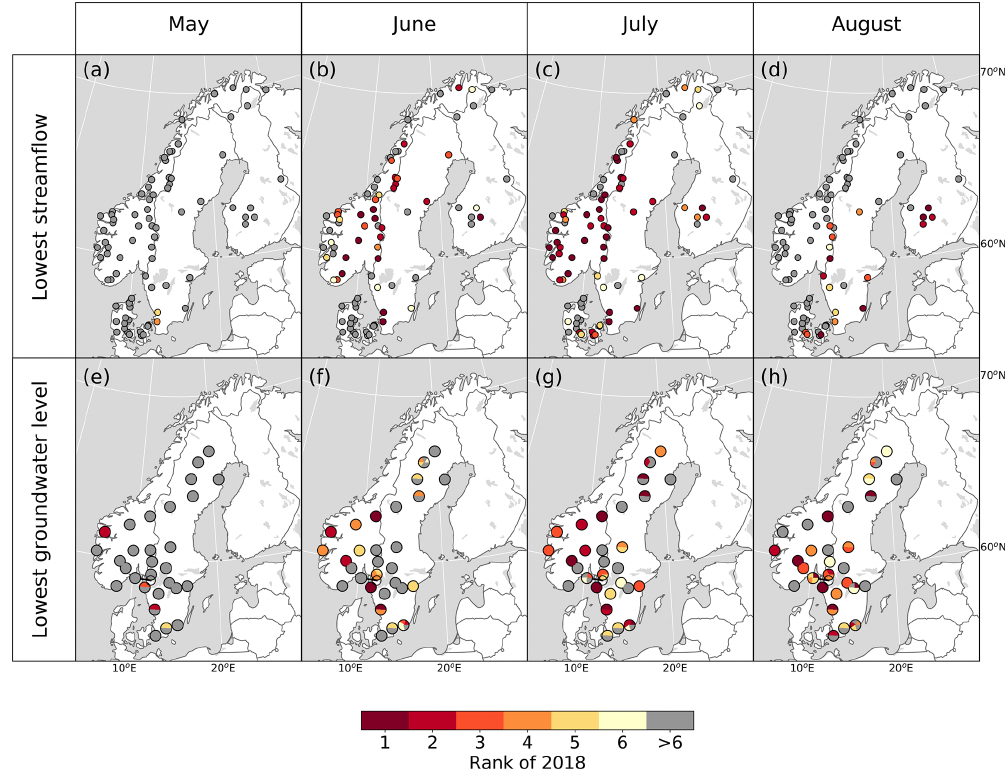
Figure 7. Top-six ranking of lowest streamflow for (a) May, (b) June, (c) July, and (d) August, and top-six ranking of 2018 lowest ground- water level for (e) May, (f) June, (g) July, and (h) August. Analysed period is 1959–2018 for streamflow and 1989–2018 for groundwater. A rank of 1 signifies that 2018 had the lowest monthly streamflow (upper panels) or groundwater level (lower panels) since the beginning of the analysed period; a rank of 2 signifies that 2018 had the second most extreme value in the given month,